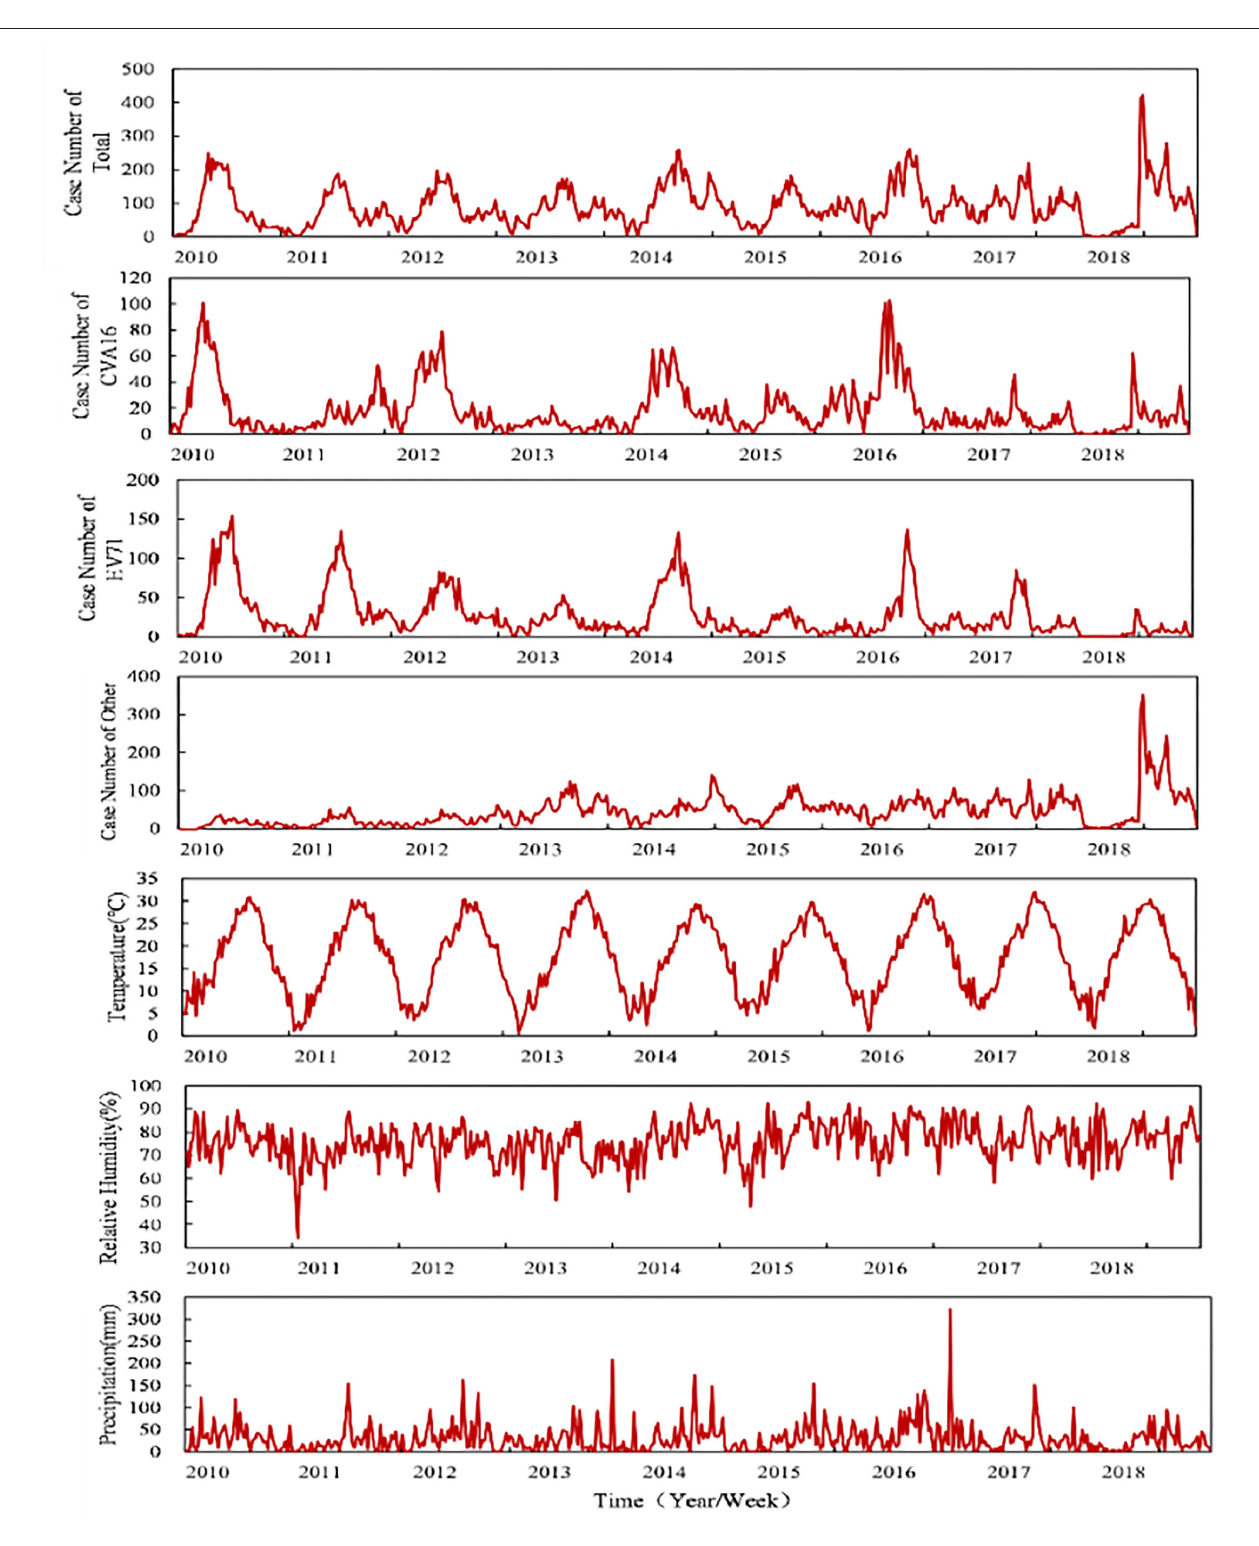
FIGURE 3 | Distributions of the three categories of HFMD and meteorological factors from 2010 to 2018.